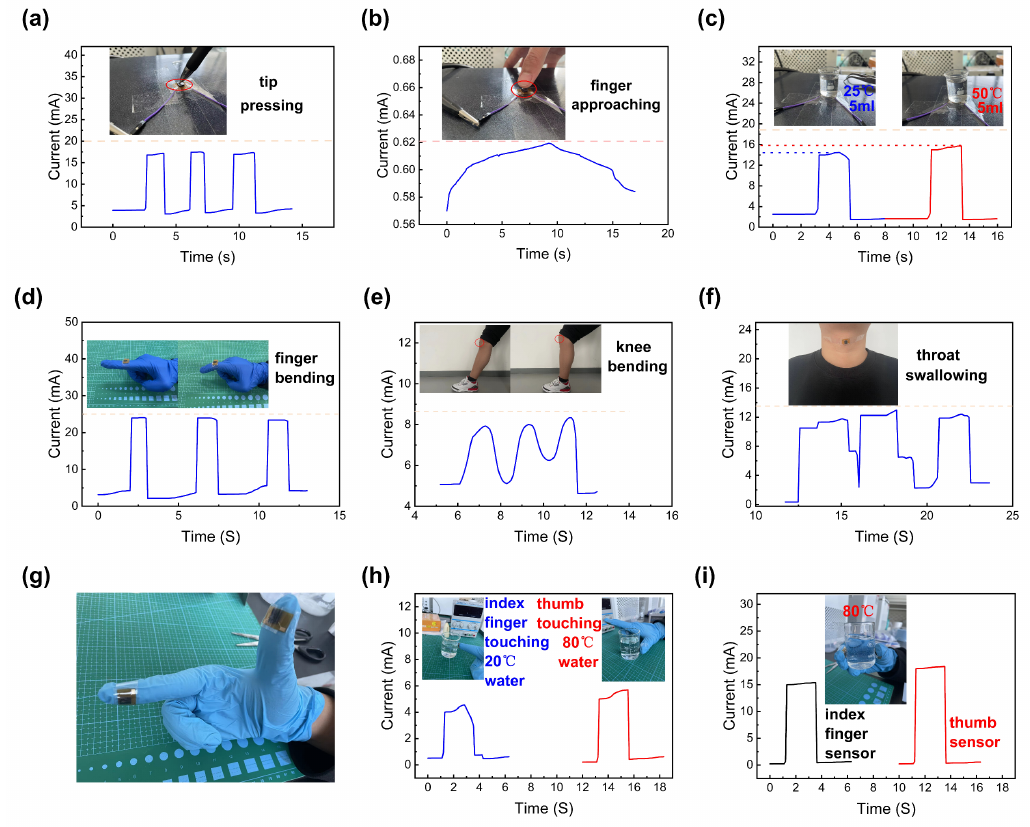
Figure 7. Real-scene tests of the sensor: ( a ) I-T curve when pressing the sensor with a pen tip; ( b ) I-T curve when finger approaches the sensor; ( c ) I-T curve when placing the sensor on a 5 mL glass of 25 °C water and 5 mL of 50 °C water; ( d ) I-T curve when the finger bends; ( e ) I-T curve when the knee bends; ( f ) I-T curve while swallowing; ( g ) the wearable sensors; ( h ) I-T curves of the two sensors when touching the water at different temperatures; ( i ) I-T curves of the two sensors when holding a beaker with 80 °C water.